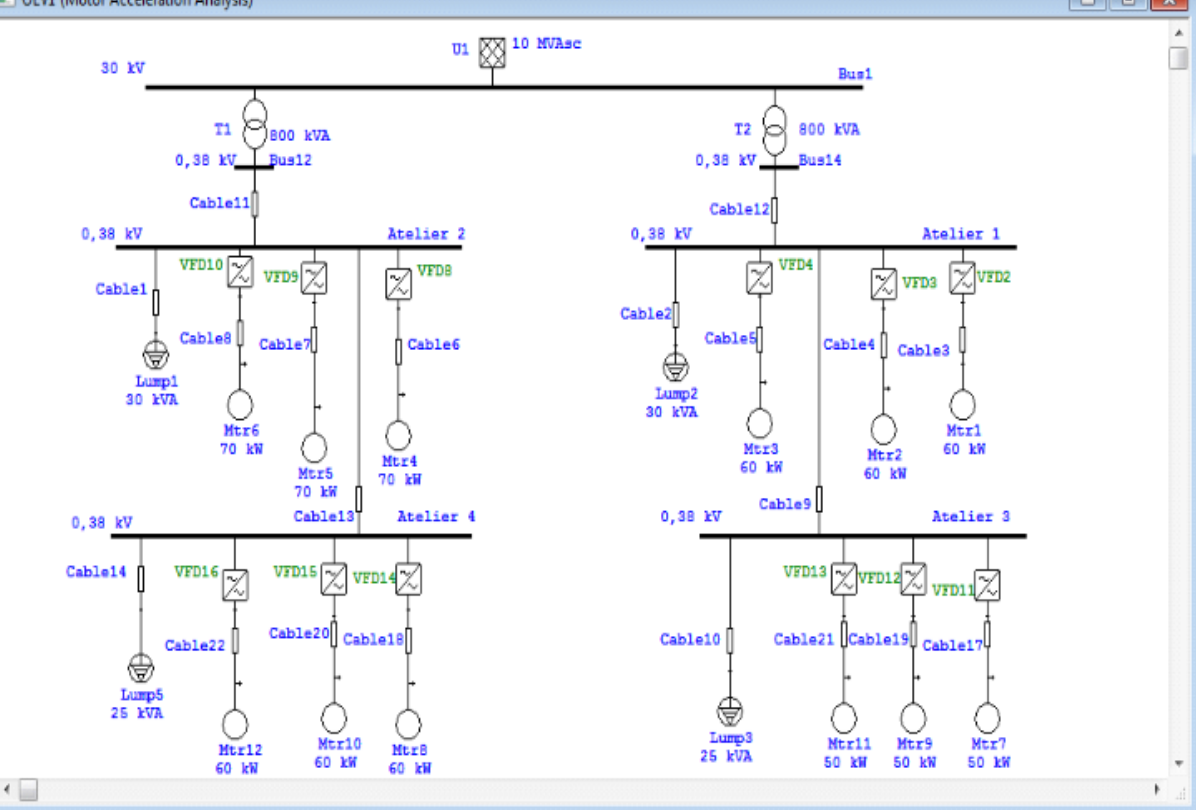
Figure 9: The insertion of VFDs into the industrial electricity